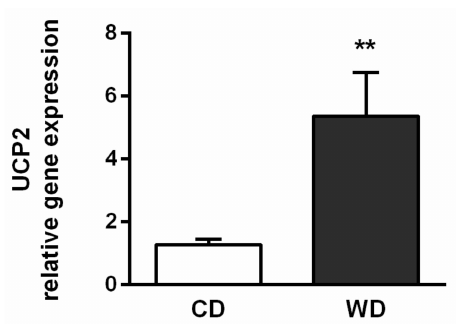
Figure 8. Uncoupling protein 2 (UCP-2) gene expression in mice fed a control diet (CD) and a Western-style diet (WD). The results are expressed as the means ± SD; ** p < 0.01 ( n = 4 each group).